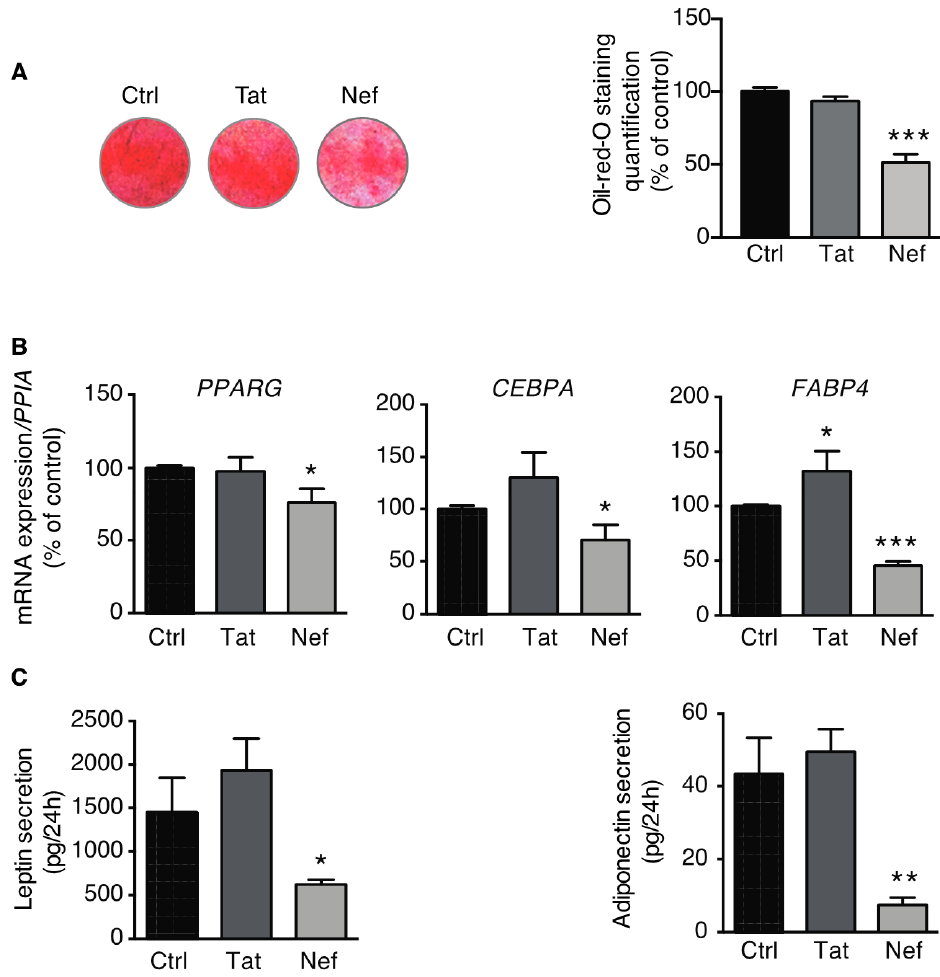
Figure 6. Nef-induced senescence was associated with impaired adipogenesis. After 30 days of treatment with Tat or Nef, ASCs, isolated from di ff erent abdominal SCAT healthy donors, were induced to di ff erentiate into adipocytes for 14 days. The Tat or Nef treatment was stopped during di ff erentiation. ( A ) Adipogenic potential of ASCs was determined using Oil-Red-O staining 14 days after the start of di ff erentiation induction. Representative pictures of cultured cells are shown (left panel), and the intensity of Oil-Red-O staining was normalized against protein content and expressed as the mean ± SEM % of control cells ( n = 4, in duplicate). ( B ) The relative mRNA expression levels of PPARG, CEBPA, and FABP4 were normalized against that of PPIA . The results are expressed as the mean ± SEM % of control cells ( n = 4, in duplicate). ( C ) Secreted leptin and adiponectin levels in the culture medium from the last 24 h of incubation were determined using ELISAs ( n = 3, in duplicate). The results are expressed as mean ± SEM. * P < 0.05, ** P < 0.01, **** P < 0.0001 vs. control cells.